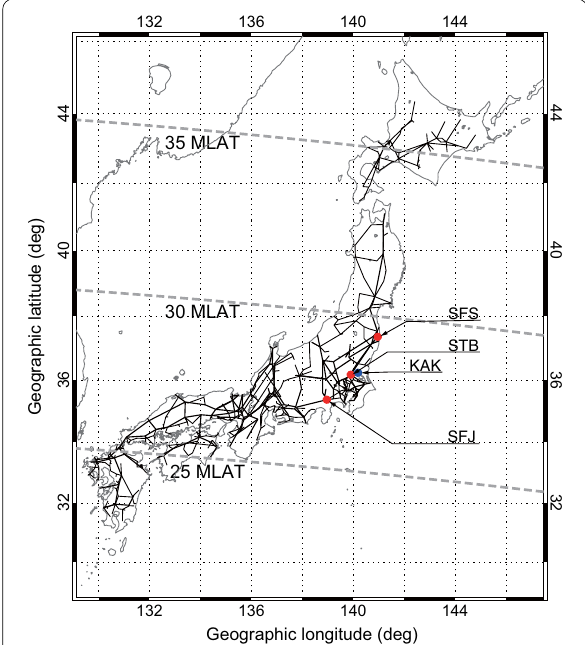
Fig. 1 Locations of the substations Shin-Fukushima (SFS), Shin-Tsukuba (STB) and Shin-Fuji (SFJ) as well as Kakioka Magnetic Observatory (KAK). Transmission lines are schematically drawn by the thick lines for 500 kV and the thin lines for 187–275 kV. The gray lines indicate the dipole geomagnetic latitudes with the geomagnetic pole locations determined by International Geomagnetic